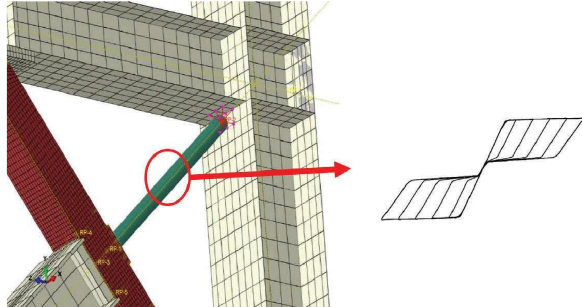
Figure 12: Placing the SMA damper between knee and beam- column